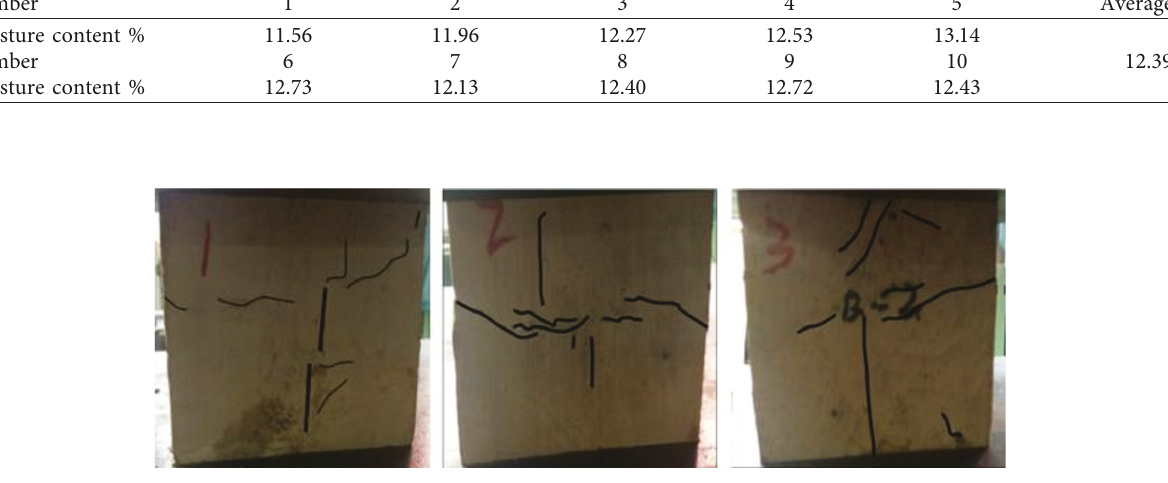
Figure 4: Failure mode of the specimen Y 1.